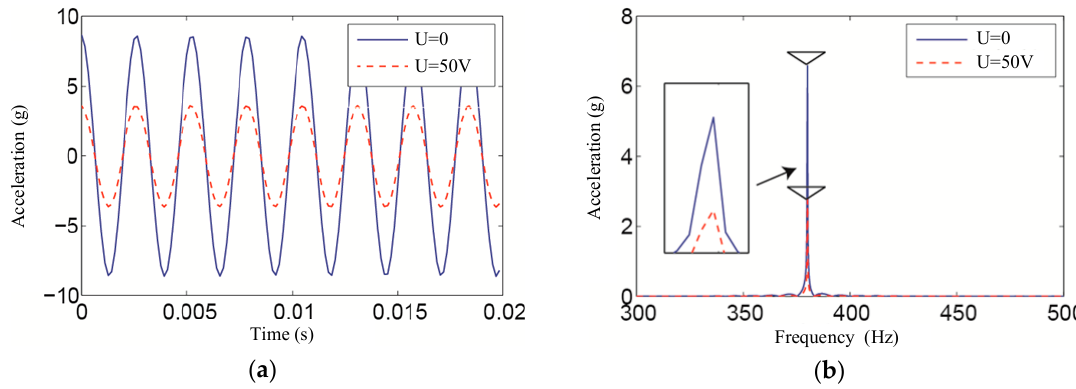
Figure 17. Vibration response in the ( a ) time domain and ( b ) frequency domain under excitation of 0.1 g.